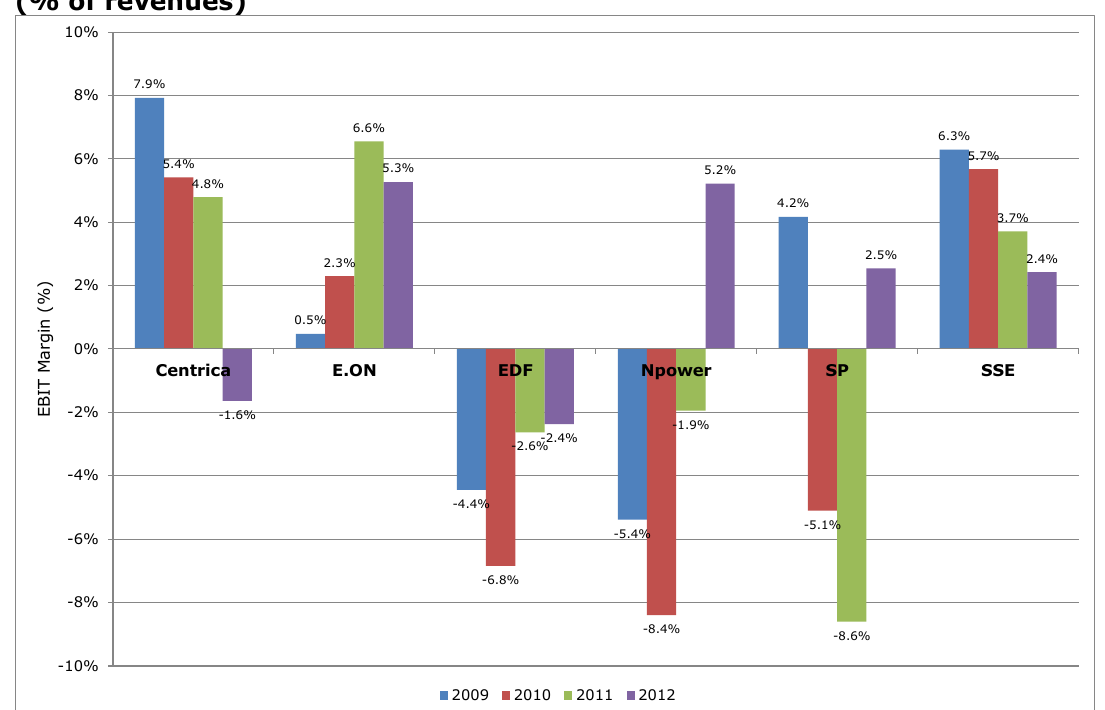
Source: Analysis of the six largest suppliers